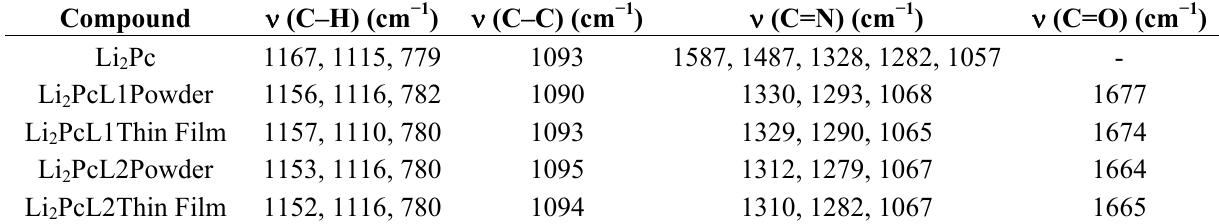
Table 1. IR (cm − 1 ) characteristic bands of the synthesized materials for powder and thin film sample